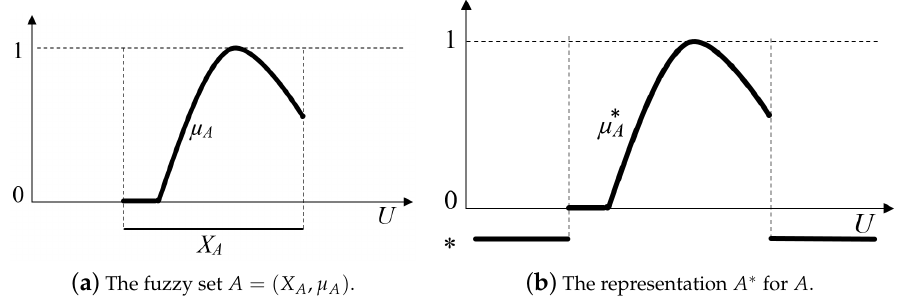
Figure 2. Representation of the fuzzy set A = ( X A , µ A ) on a universe U ⊇ X A